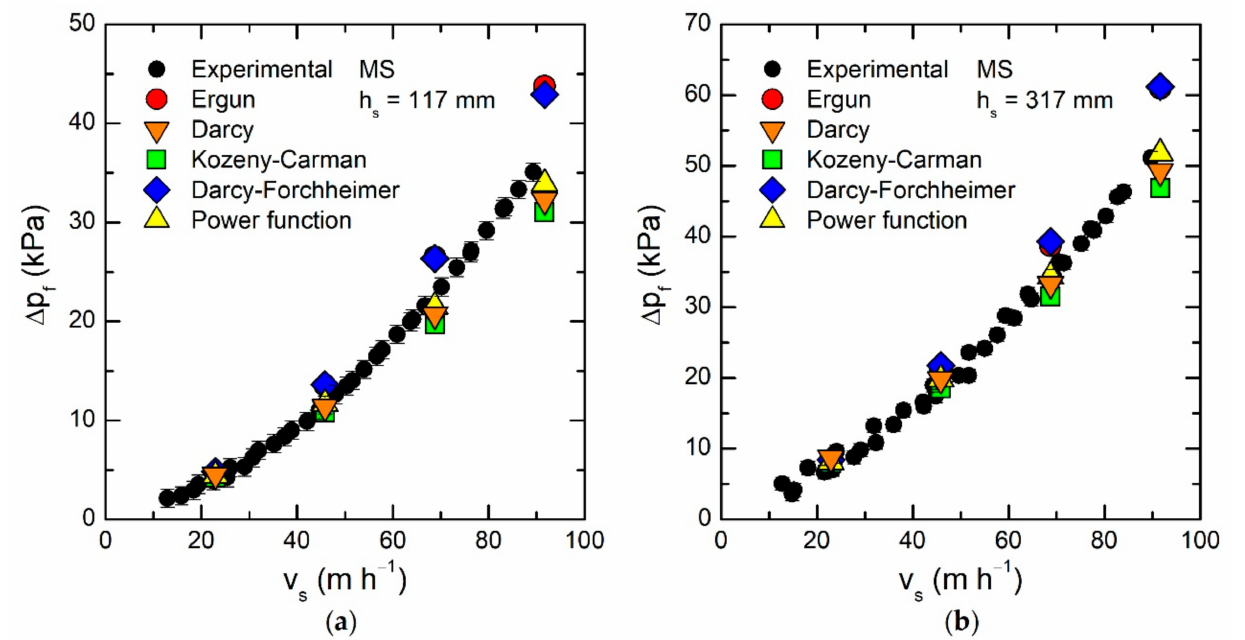
Figure 7. Filter pressure drop as a function of the superficial velocity experimentally observed and simulated using Equations (7)–(11) for the porous media (MS) with micro spheres height above the base plate equal to ( a ) h s = 117 mm; ( b ) h s = 317